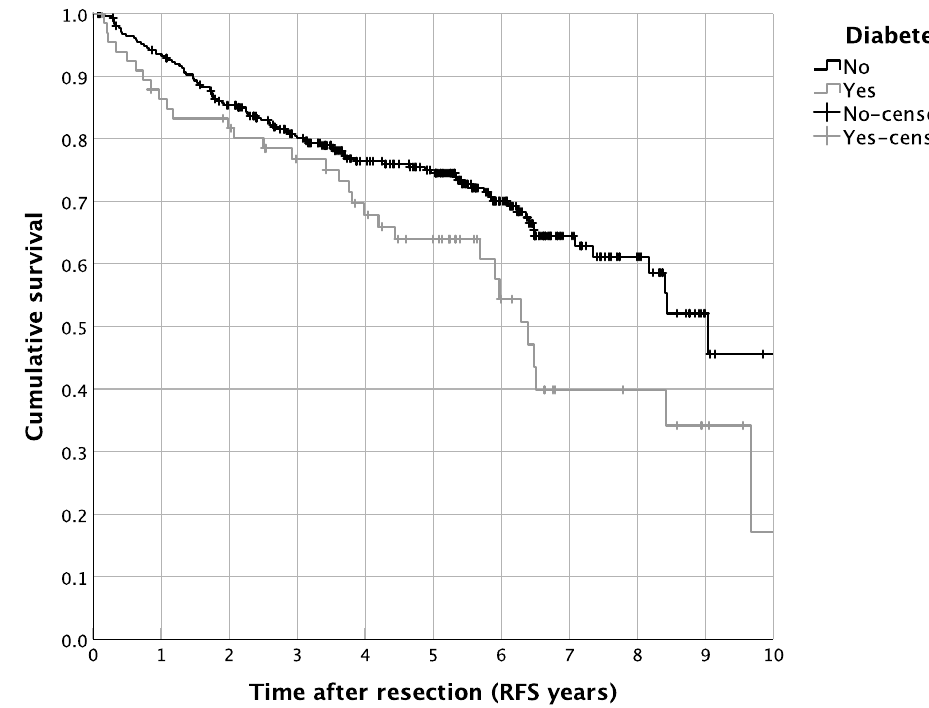
Figure 2. Survival of HNM patients differentiated by a diagnosis of diabetes: Kaplan–Meier curves for RFS ( p = 0.018, n = 382, diabetic patients: n = 68). Table 3. Synopsis of the results from the multivariable Cox regression for RFS and cumulative recurrence rates according to metformin use and diabetes in the complete cohort.